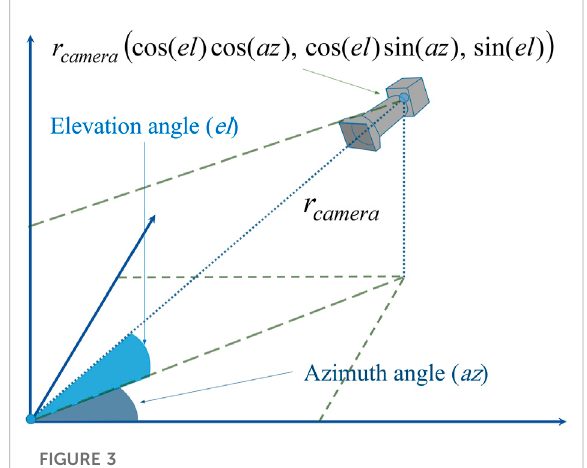
FIGURE 3 A description of the location of the camera in 3D